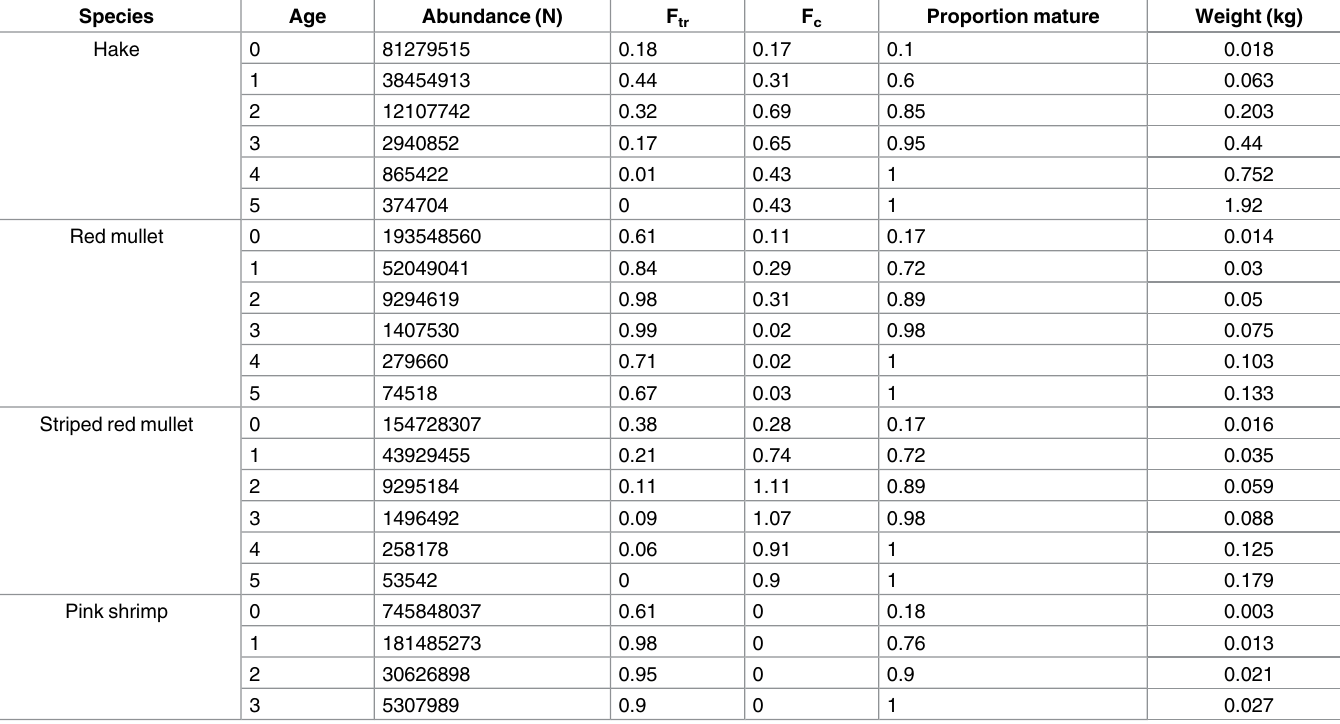
Table 1. Abundance, fishing mortality, proportion mature and weight estimatesat-age by